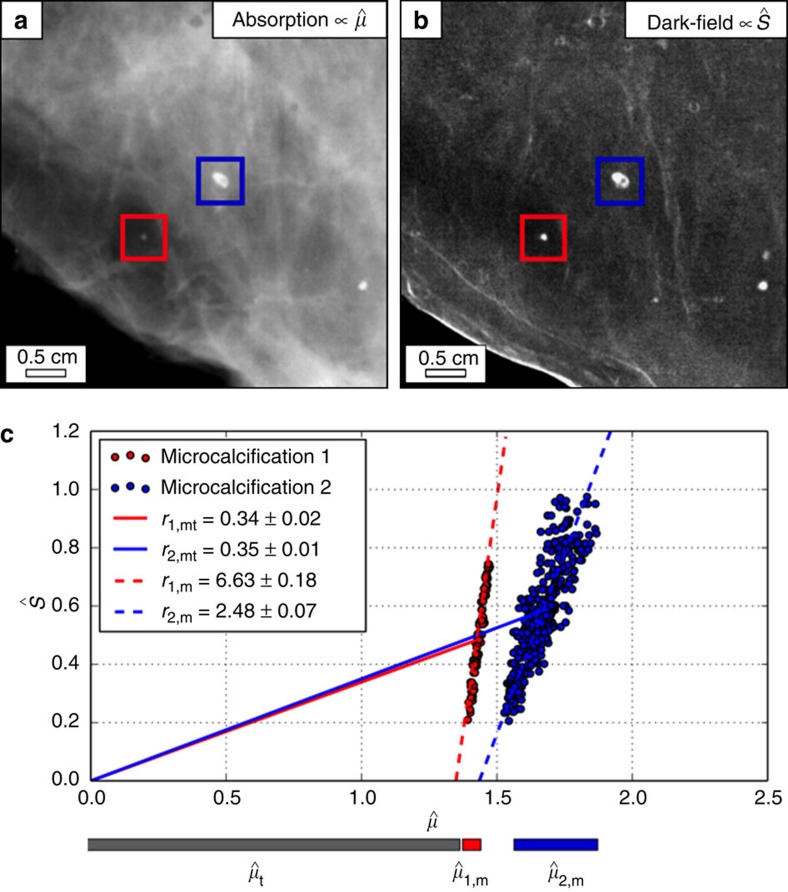
Quantitative evaluation of microcalcification analysis in X-ray dark-field mammography.(a) Experimental absorption and (b) dark-field mammogram of a freshly dissected breast abladate with microcalcifications. (c) Scatter plots comparing the absorption  to scattering power  of two exemplary microcalcifications cluster, as indicated by the blue and red frame in (a, b), respectively. An incorrect r-value is obtained (rWang=rmt) if contributions of the underlying tissue are neglected in the analysis, since >>.